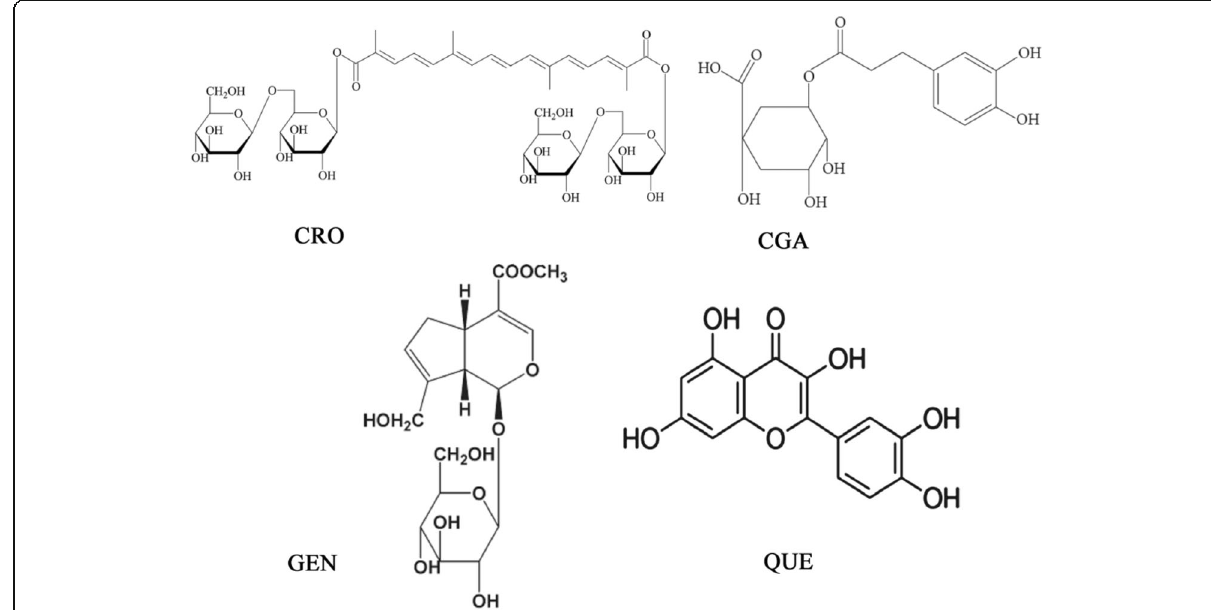
Fig. 1 Chemical structures of CRO, CGA, GEN and QUE